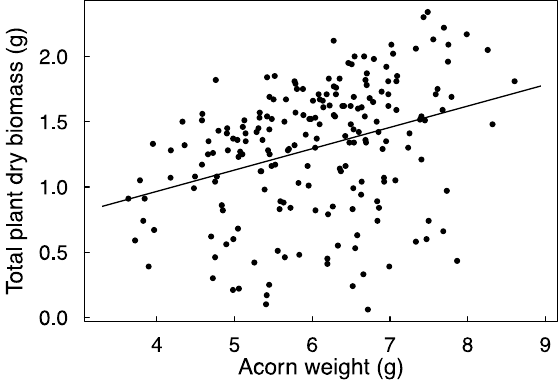
Figure 2. Relationship between acorn weight and plant dry biomass. The line represents a simple linear regression line (the significance of this effect was assessed with mixed effects models; see Methods). R 2 conditional of the model (i.e., variance explained by fixed and random effects combined) is 0.21.